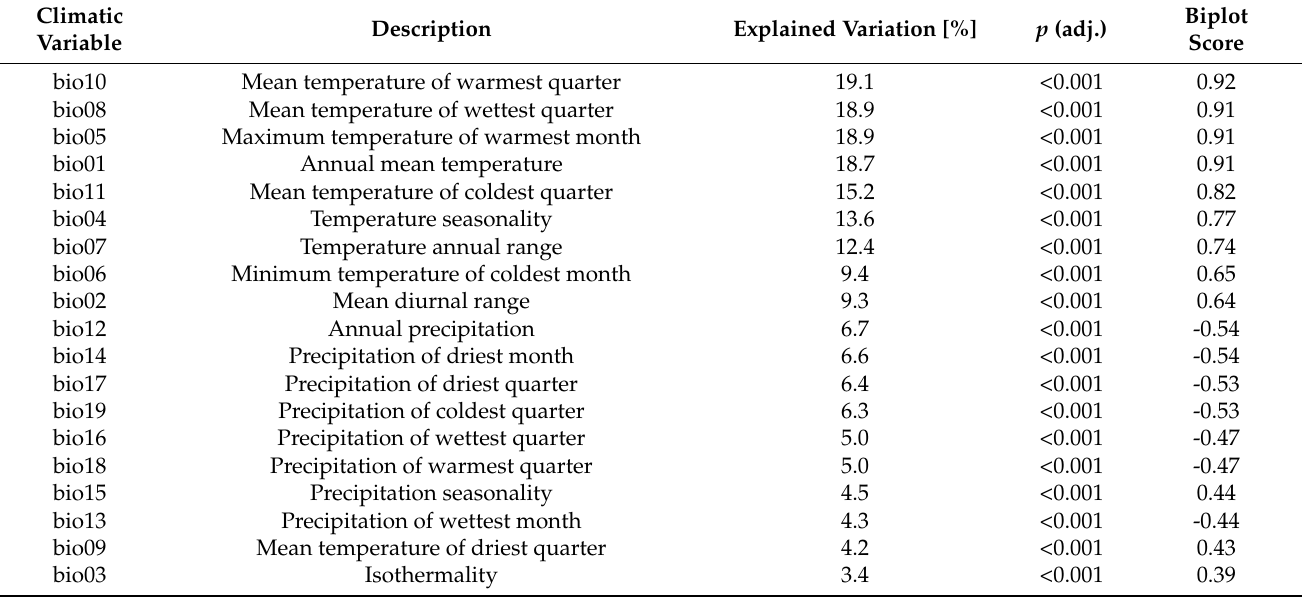
Figure 8. Numbers of individual records of Cyperus fuscus in the Czech Republic. Thin grey line–frequency curves; thick dashed line–11-year moving average; thick solid line–moving average corrected for botanical activity. Whiskers represent 99% confidence intervals of the means. Table 4. Climatic variables and their significance in the canonical discriminant analysis (CDA). Biplot scores of explanatory variables represent the contribution of climatic variables to the first canonical axis separating presences and absences of Cyperus fuscus [77]. Climatic variables with positive biplot score values are positively correlated with C. fuscus occurrence, variables with negative values are positively correlated with C. fuscus absence. The significance was adjusted using the false discovery